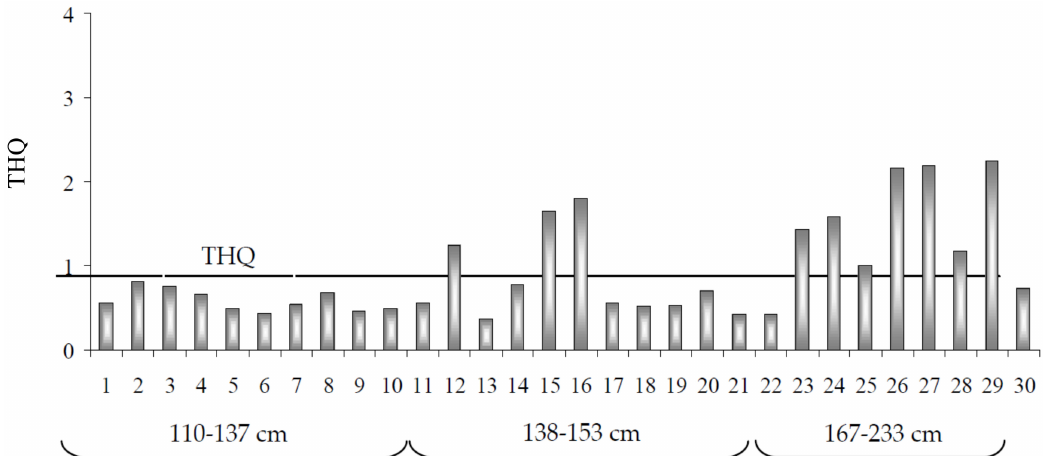
Figure 3. Estimated Target Hazard Quotient (THQ) for Hg and MeHg by consumption of different swordfish size spectra.